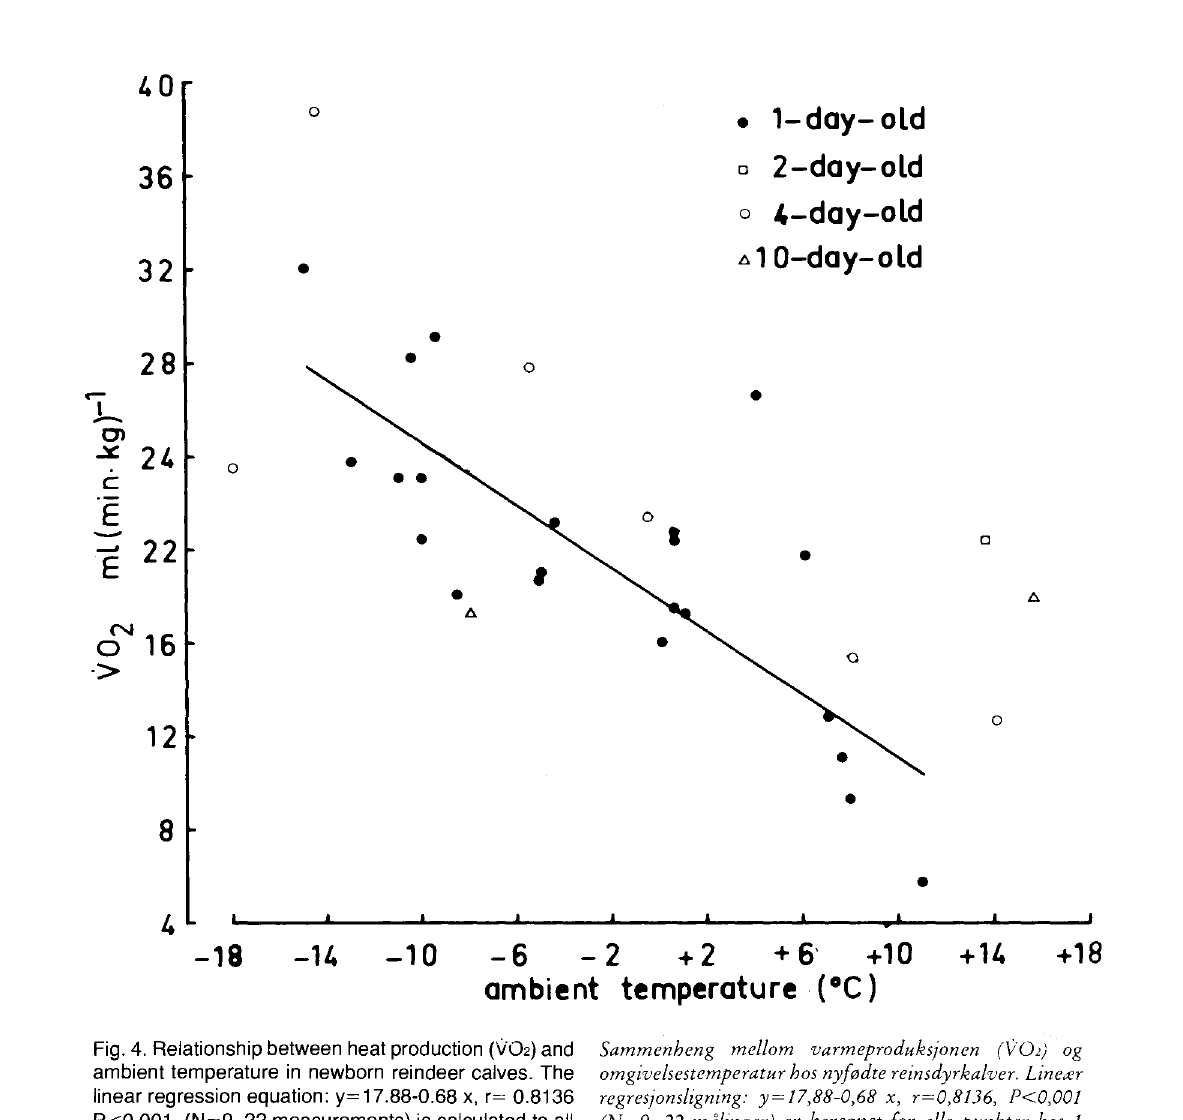
Fig. 4. Relationship between heat production (VO2) and ambient temperature in newborn reindeer calves. The linear regression equation: y= 17.88-0.68 x, r= 0.8136 P<0.001, (N=9, 22 measurements) is calculated to all points of 1 day old calves by the method of least squares.